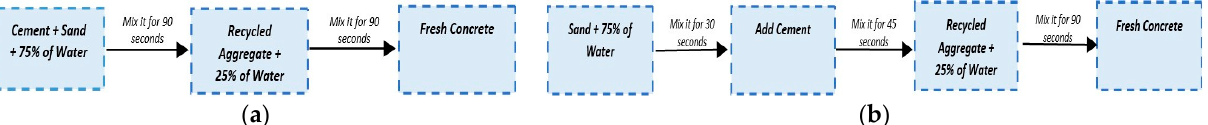
Figure 3. Schematic diagram of ( a ): the Mortar Mixing Approach (MMA) method; and ( b ) the Sand- Enveloped Mixing Approach (SEMA) method [42]